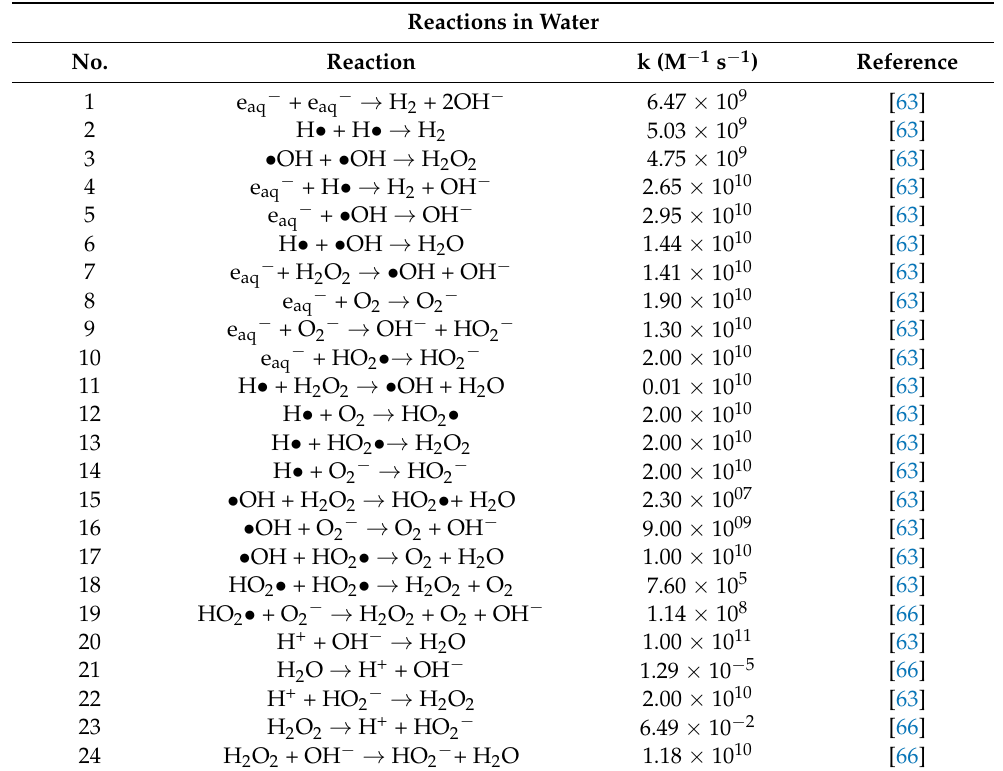
Table 5. Reaction set used in the simulation of the chemical and biological stages for the radiolysis in water [63,66] and associated rate